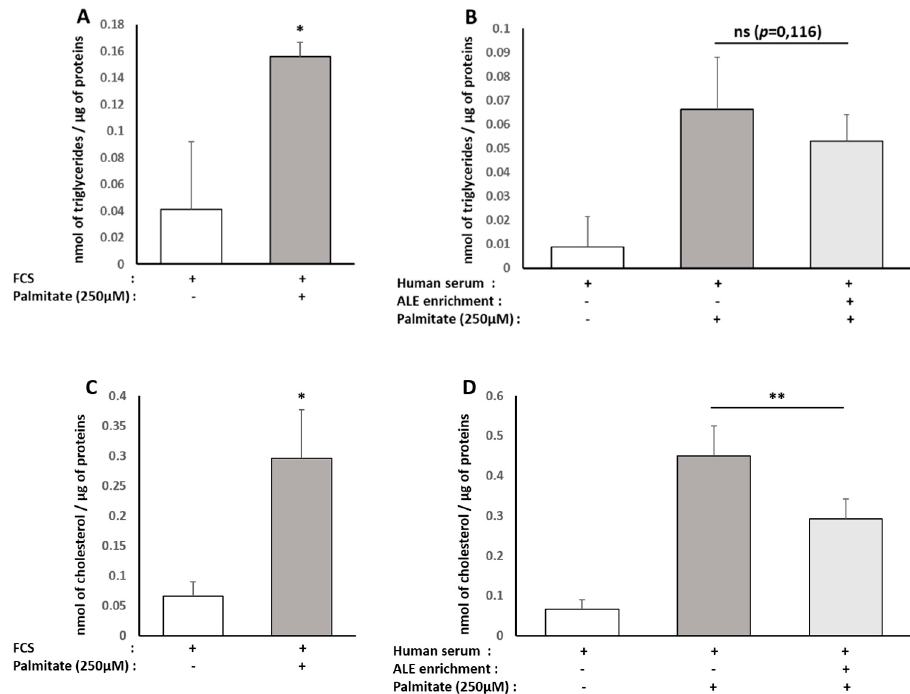
Figure 6. Effect of human serum enriched with ALE metabolites on cholesterol and triglyceride levels in HepG2 cells. HepG2 cells were preincubated with fetal calf serum for 24 h and stimulated with 250 µ M palmitate or vehicle for an additional 48 h ( A , C ). To analyze the effects of human serum enriched with metabolites, cells were preincubated for 24 h in DMEM in the presence of 10% of human enriched serum according to the Clinic’n’Cell protocol (DIRV INRA 18-00058) prior to an additional 48 h treatment palmitate (Sigma, St. Louis, MO, United States) at 250 µ M. Intracellular triglycerides ( A , B ) and total cholesterol were measured ( C , D ). Palmitate stimulated HepG2 triglyceride and cholesterol content independently of the origin of the serum (calf or human). The human serum enriched with ALE metabolites significantly limited the intracellular cholesterol levels. * ( p < 0.05); ** ( p < 0.01); ns : no significant difference.